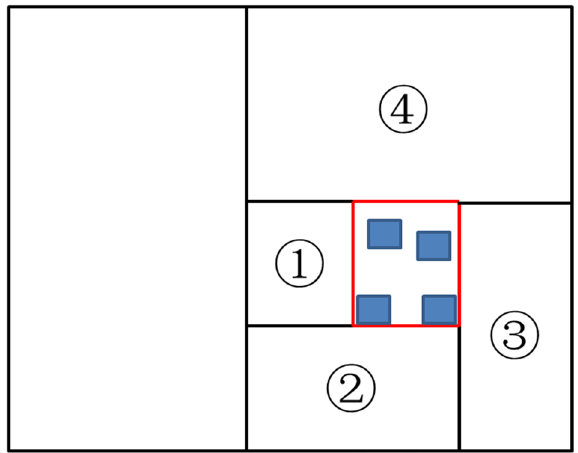
Fig. 10 The instance of query dynamic clusters. In the figure 10, the rectangle outlined in red represents a example of sum‑marized clustering